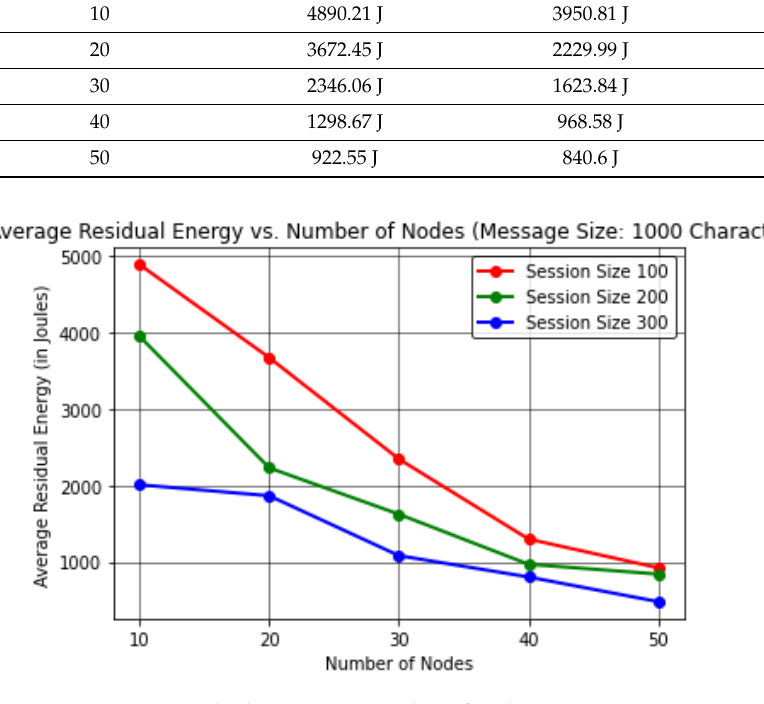
Figure 11. Average residual energy vs. number of